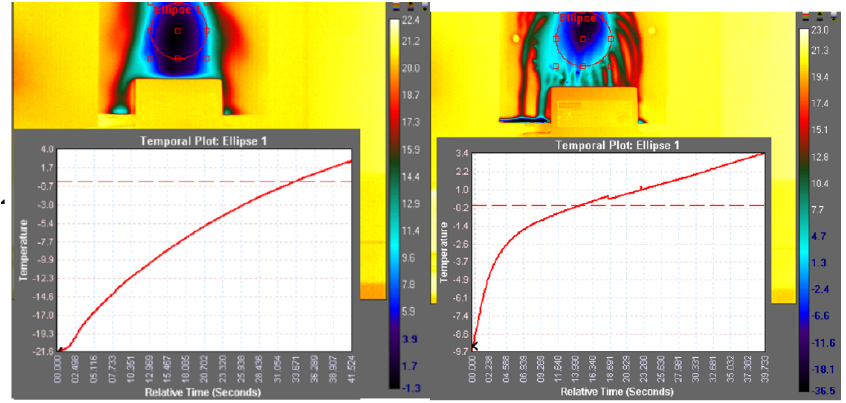
Figure 11. Sample mean temperature variation in a period of 40 s.